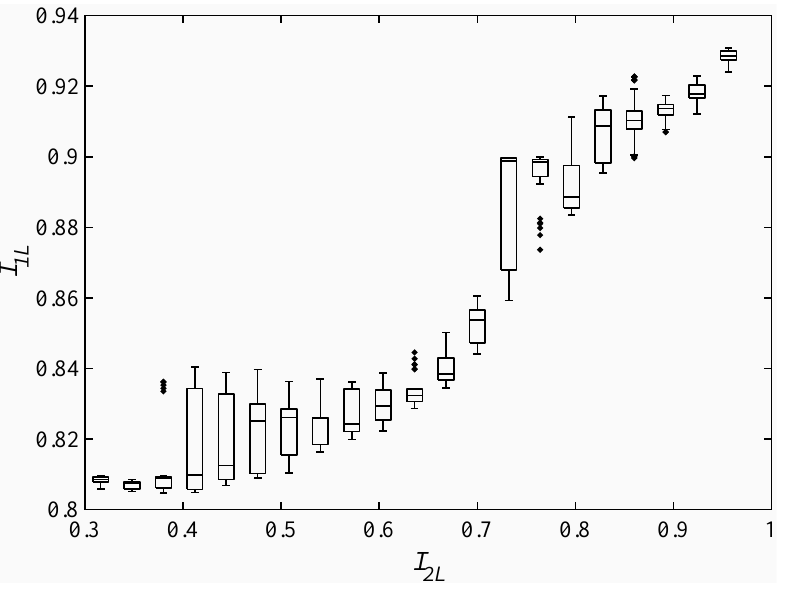
Figure 11. Boxplot representation of First Law Index I 1 L against Second Law Index I 2 L . TTES facilities base their capacity in the stratification. The Mean Temperature Gra- dients represent the slope of temperature in height. Situations of good stratification are identified with high MTG 90 and MTG 70 values, letting MTG 70 for the temperature slope in the central thermocline region and MTG 90 for a wider